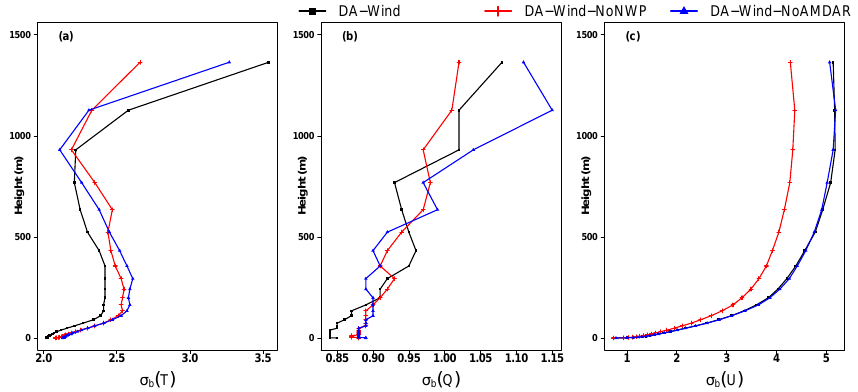
Figure 2. Background error standard deviation for ( a ) temperature ( ◦ C), ( b ) specific humidity (g · kg − 1 ), and ( c ) zonal wind (m · s − 1 ) for DA-Wind, DA-WindNoNWP and DA-WindNoAMDAR experiments.